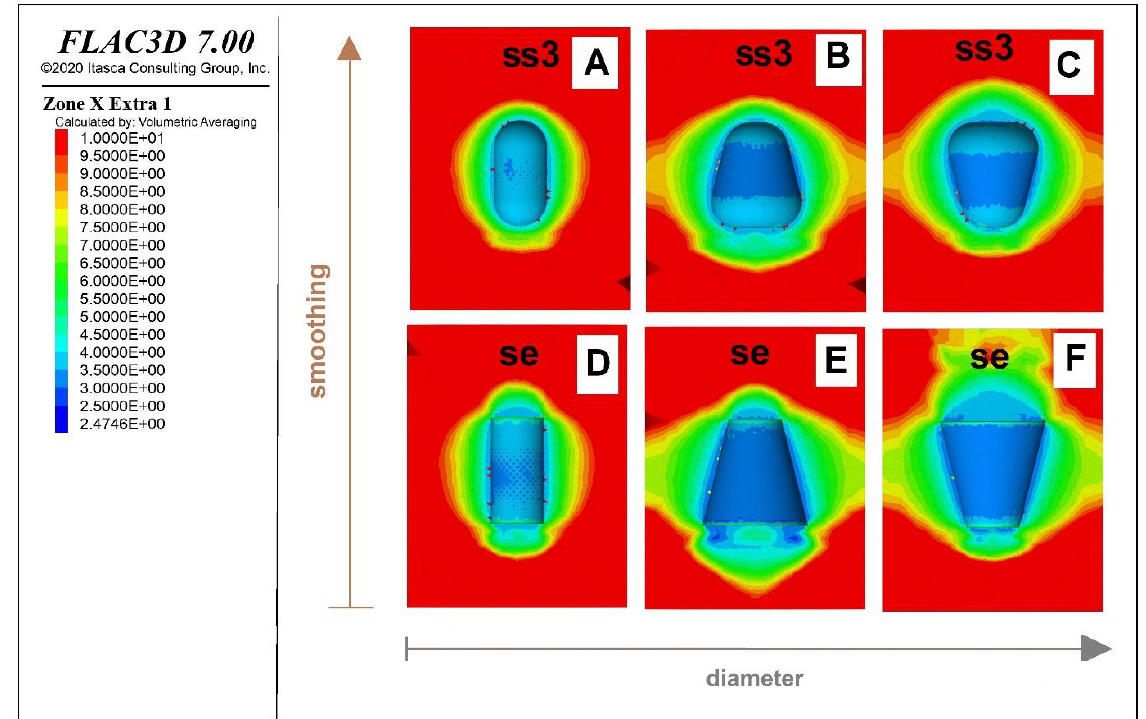
Figure 22. The low SF distribution in caverns; the last withdrawal period: ( A , D ) cylindrical shape, ( B , C , E , F ) maximum initial diameter of 120 m.